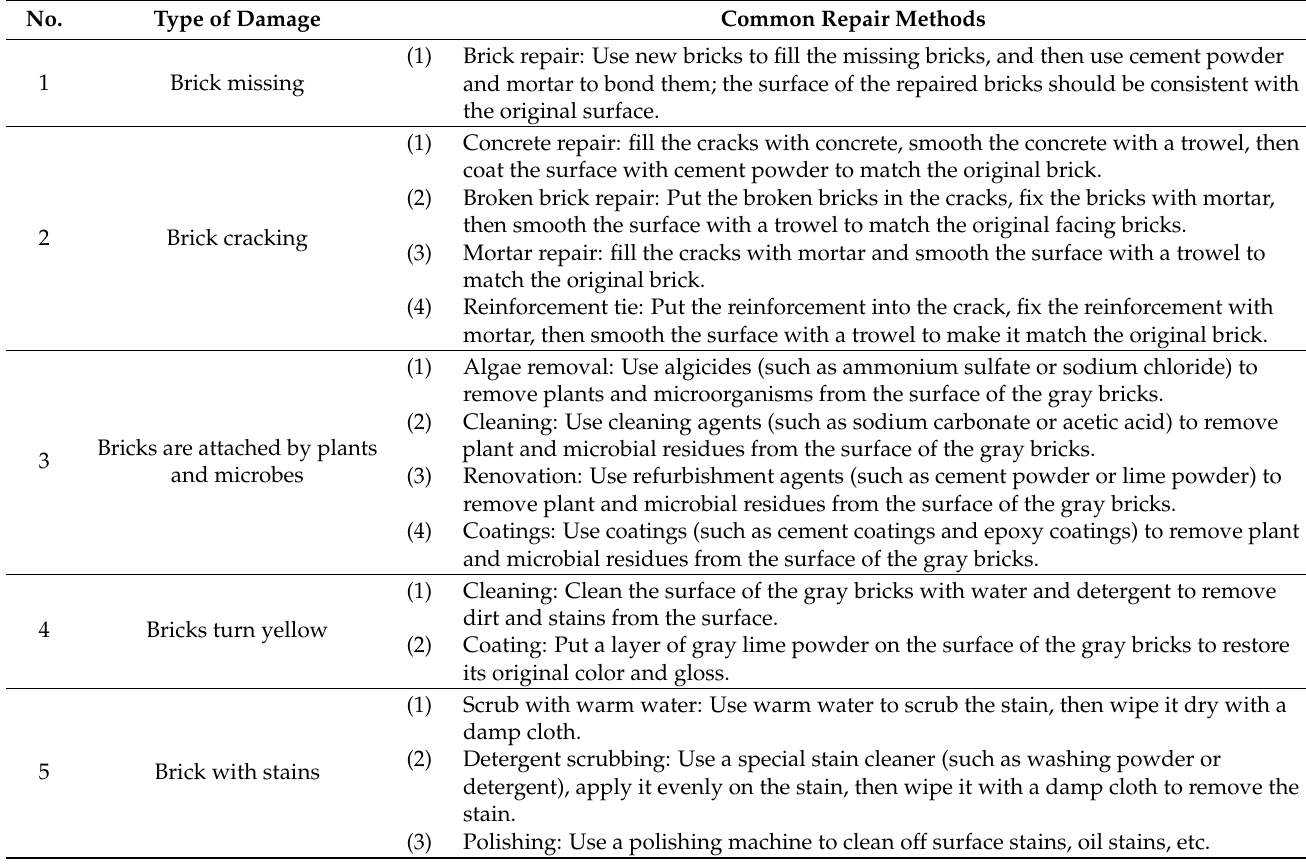
Table 2. Types of gray-brick damage and common repair